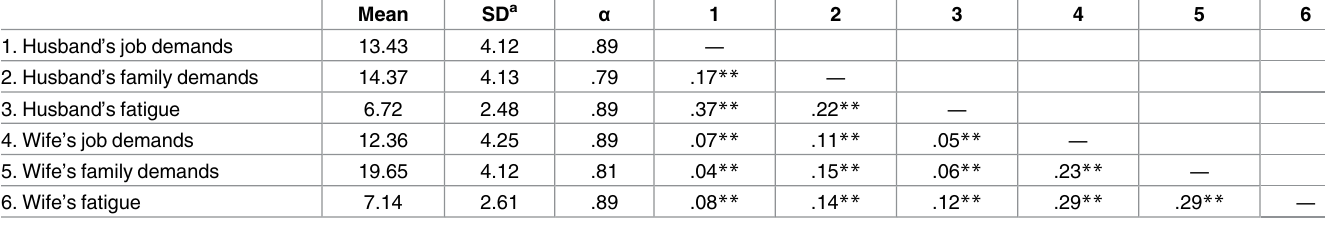
Table 2. Means, standard deviations, Cronbach’s alpha, and correlations for the model variables.